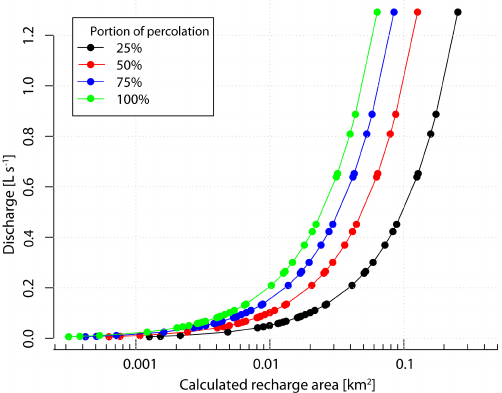
Figure 5. Estimated size of recharge area based on average dis- charge and annual water input of 643mm (Pfeiffer et al., 2021). The recharge area size was derived from Eq. (2) for four different infiltration ratios I c (25%, 50%, 75%, and